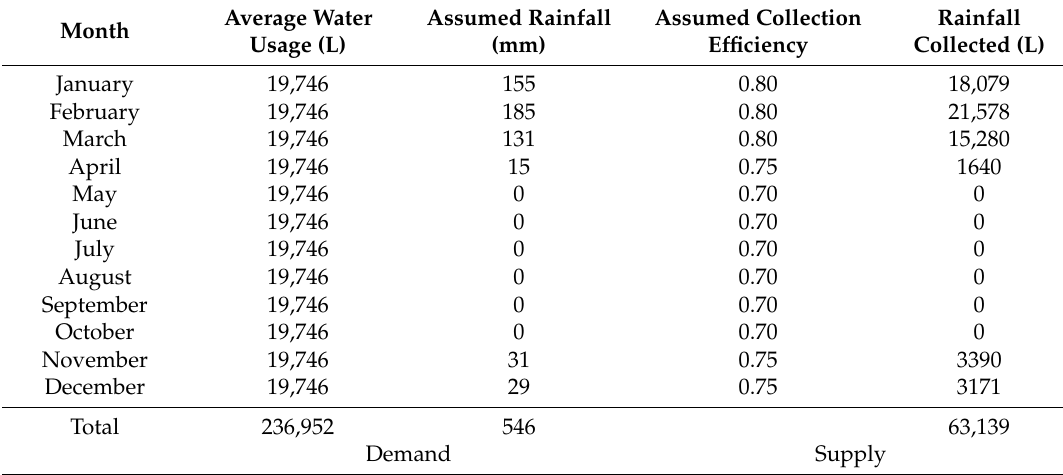
Table 7. Rainfall collected in the Yatta